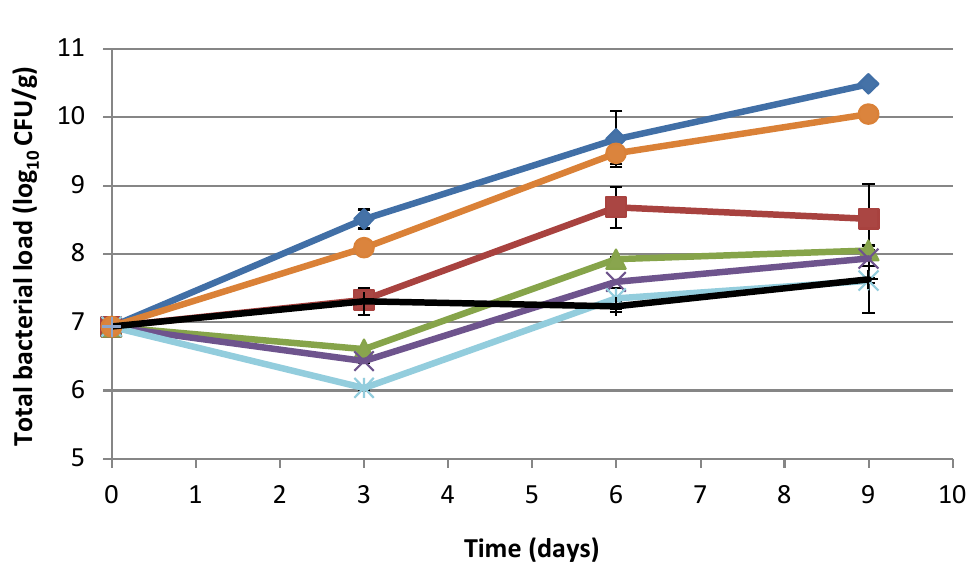
Figure 1. Effect of fermented byproduct extracts on food preservation. Total bacterial load (log 10 CFU/g) in minced pork meat with or without fermented tomato byproduct extract/preservative. Minced meat (blue line) and minced meat with 0.8% fermented tomato byproduct extract (red line), 1.2% fermented tomato byproduct extract (green line), 1.6% fermented tomato byproduct extract (purple line), 2.4% fermented tomato byproduct extract (light blue line), 1.2% sodium lactate (orange line), and 2.5% sodium lactate/sodium diacetate (96:4) (black line).